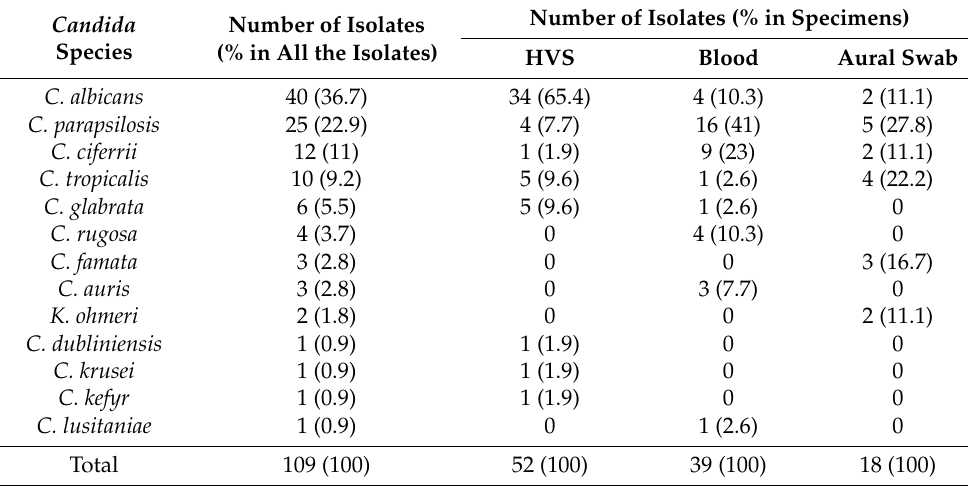
Table 1. Incidence of Candida species from three clinical specimens (n =